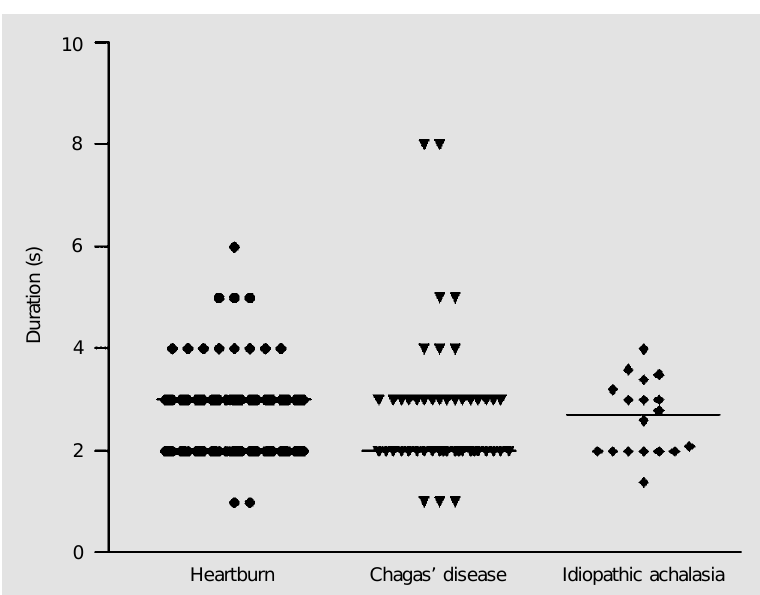
Figure 2. Duration of esophageal striated muscle contractions in patients with heartburn, Chagas’ disease or idiopathic achalasia. The horizontal lines indicate the